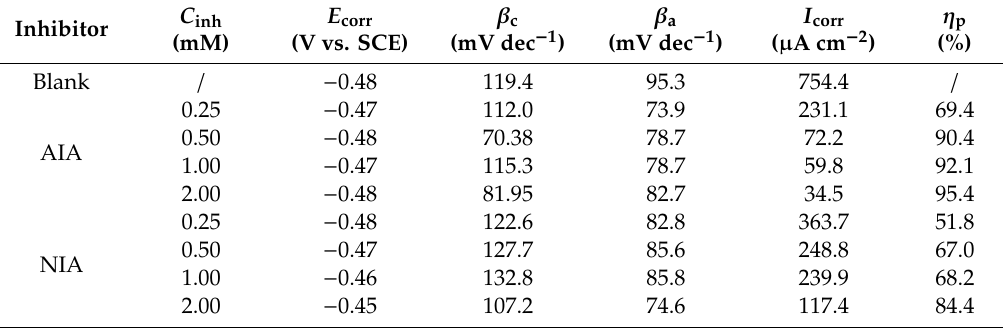
Figure 4. Anodic and cathodic polarization curves for carbon steel in 1 M HCl with various concentrations of ( a ) AIA and ( b ) NIA at 298 K. SCE: saturated calomel electrode. Table 2. Relevant parameters for Q235 steel in 1 M HCl solution in the absence and presence of di ff erent concentrations of AIA and NIA at 298 K from polarization